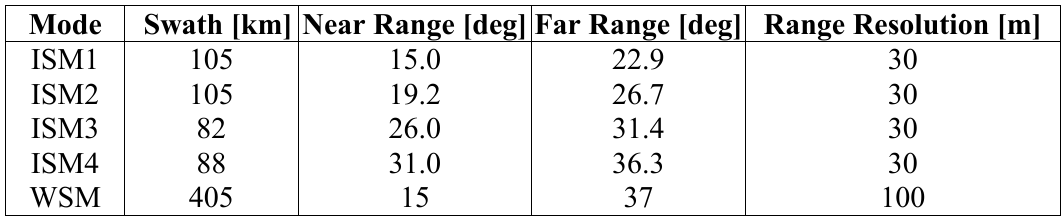
Table 1. Some parameters of the ASAR illuminator in Image Swath and Wide Swath Modes. Note that both the swath and the ground range resolution refer to the backscattering acquisition; regarding the latter, its value is related to a nominal incidence angle (e.g., 23° for